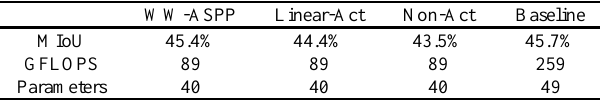
Table 4. Precision of Different DW-PW Block Design